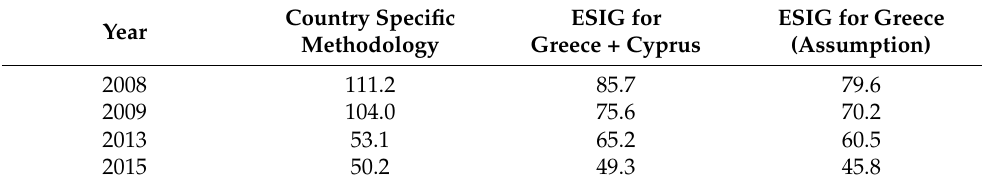
Table 5. NMVOC emissions (kt) as per Country Specific Methodologies and ESIG